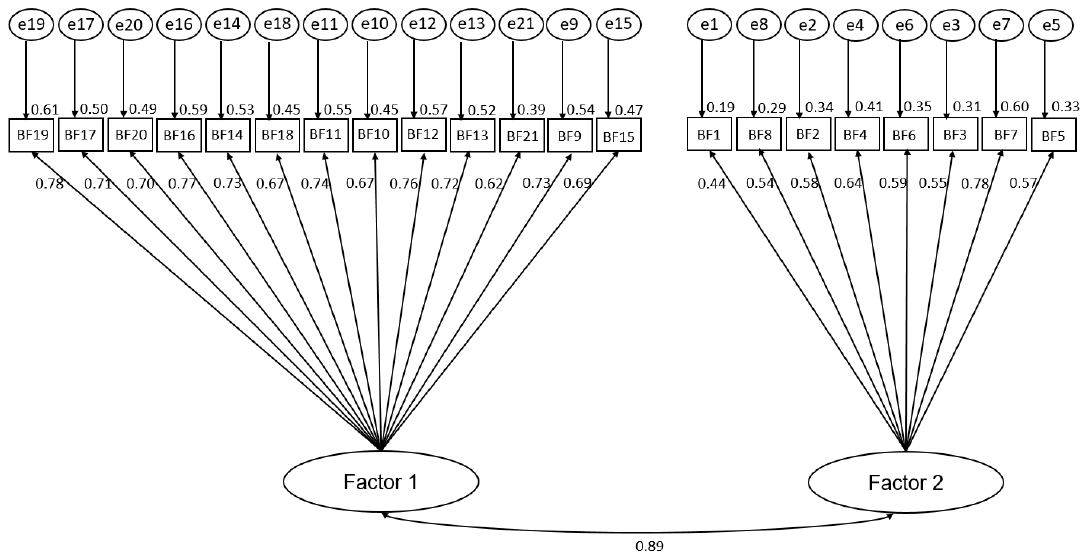
Figure 1. Path diagram of BFQ, showing standardized coefficients from confirmatory factor analysis ( N = 265). Factor 1: Changes in sense of values and way of thinking; Factor 2: Changes in relationships with others.